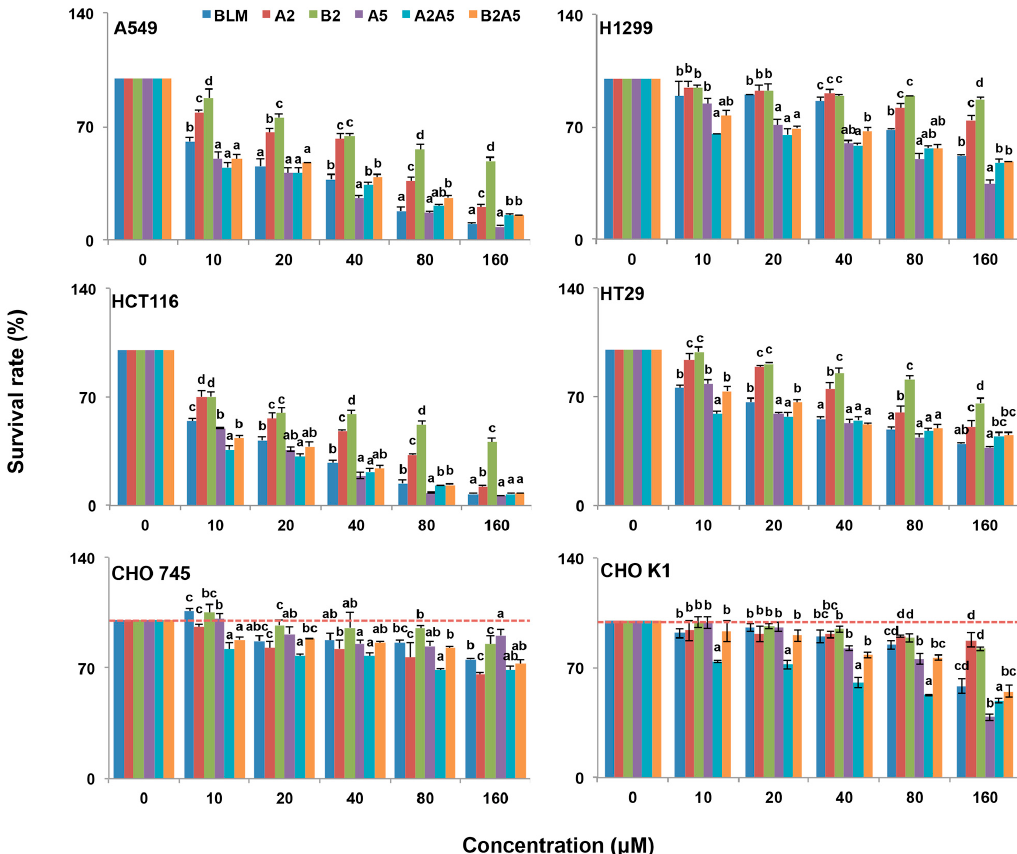
Figure 3. Growth inhibitory effect of BLMs on A549, H1299, HCT116, HT29, CHO745 and CHOK1 cell lines. Two human lung cancer cell lines A549 and H1299, two human colon cancer cell lines HCT116 and HT29, and two Chinese hamster ovary cell lines (CHO745 and CHOK1) were used to measure the percentage of viable cells after 48 h exposure to 0–160 μ M BLM (A2B2), A2, B2, A5, A2A5 and B2A5. The experiment was repeated three times with similar results. The untreated cells (control) were assigned values of 100 and the results were presented as mean ± S.D. ( n = 3). Different letters (a, b, or c) in each concentration group mean significant differences (ANOVA with Tukey test for multiple comparisons, p < 0.05).